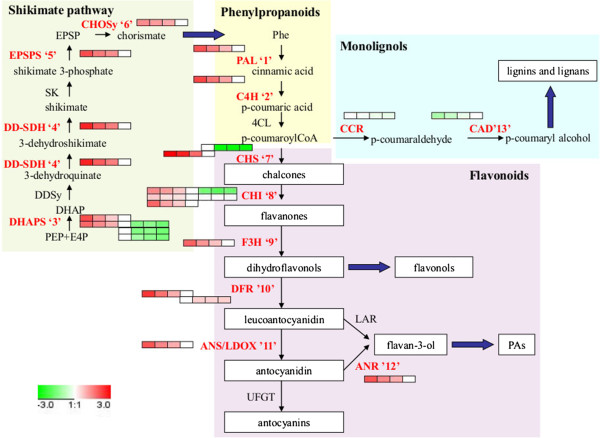
Scheme of the polyphenol biosynthetic pathways in grape berries during development and ripening. These include shikimate pathway as the phenylalanine (Phe) source, the general phenylpropanoid pathway and the branches of monolignols and flavonoids, including flavonols, proanthocyanidins (PAs) and anthocyanins (ACs) The protein levels of the regulated enzymes are shown in coloured squares, indicating the change of expression (log2 ratio) for each developmental stage in relation to the 15 mm stage. In sequence order (left to right), stages are displayed from FS, 4 mm, 7 mm, 15 mm, V-100, 110 g/l, and 140 g/l. Different isoforms or subunits of proteins are shown as different rows. The enzyme names for each catalytic step are indicated in red if differentially expressed and identified, or in black if not detected. PAL, phenylalanine ammonia lyase; C4H, cinnamate-4-hydroxylase; 4CL, 4-coumarate CoA-ligase; CHS, chalcone synthase; CHI, chalcone isomerase; F3H, flavonoid 3-hydroxylase; DFR, dihydroflavonol 4-reductase; ANS/LDOX, anthocyanidin reductase/leucoanthocyanidin dioxigenase; UFGT, UDP-glucose flavonoid 3-O-glucosyltransferase; ANR, anthocyanidin reductase; LAR, leucoanthocyanidin reductase; CCR, cinnamoyl-CoA reductase; CAD, cinnamyl alcohol dehydrogenase; DHAPS, 3-deoxy-d-arabino-heptulosonate 7-phosphate synthase; DD-SDH, dehydroquinate dehydratase shikimate:nadp oxidoreductase; EPSPS, 5-enol-pyruvylshikimate-phosphate synthase; CHOSy, chorismate synthase.